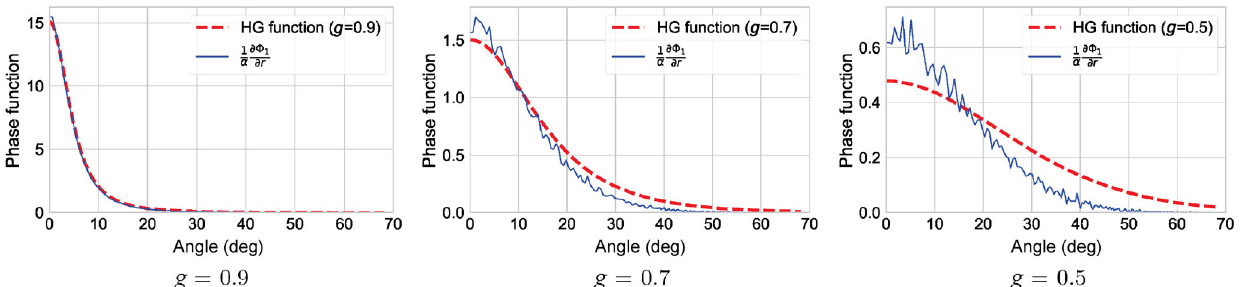
Fig. 2 Simulation result. Red line: HG function. Blue line: derivative of Φ 1